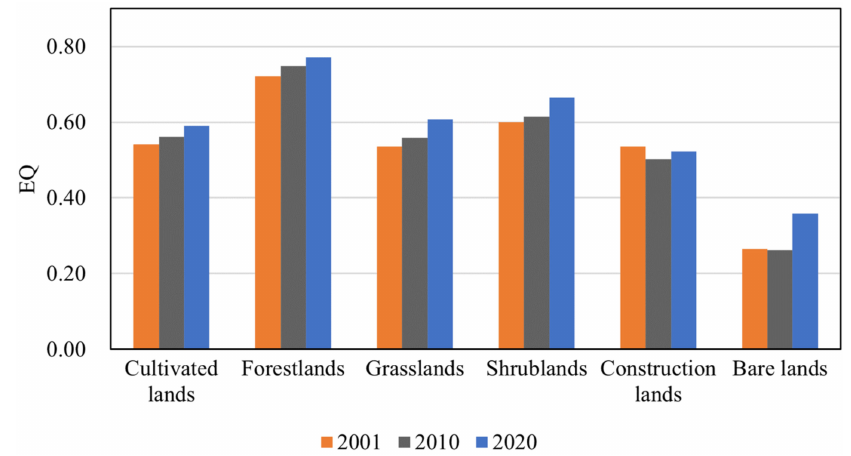
Figure 9. EQ of various land use types in 2001, 2010, and